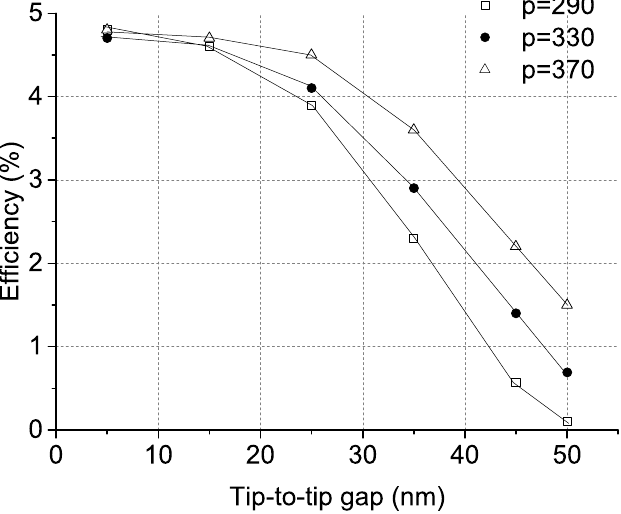
Figure 5. Efficiency versus tip-to-tip gap for three gratings with different periods. The efficiency decreases as a function of the tip-to-tip gap and increases as a function of the period